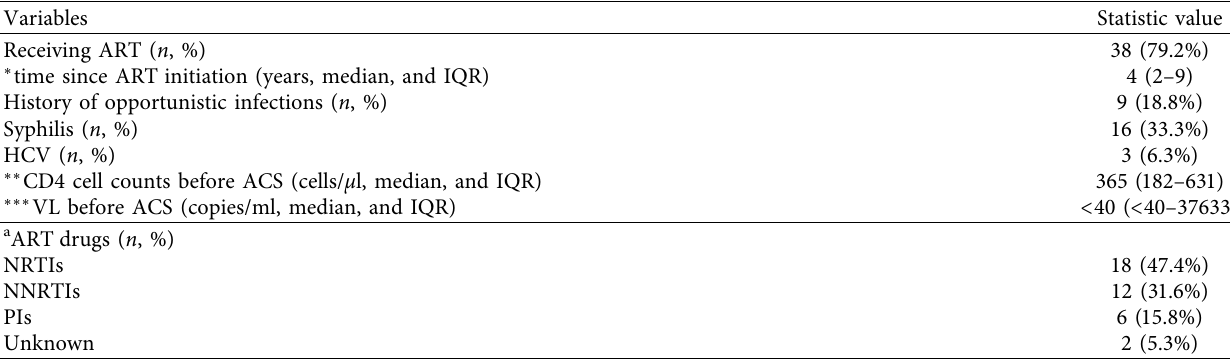
Table 2: HIV-related characteristics at admission.